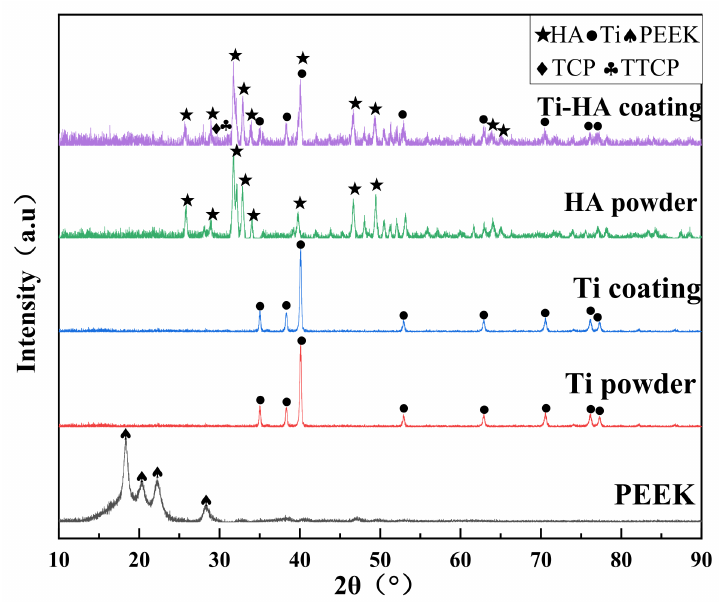
Figure 9. XRD spectrums of the original powder and